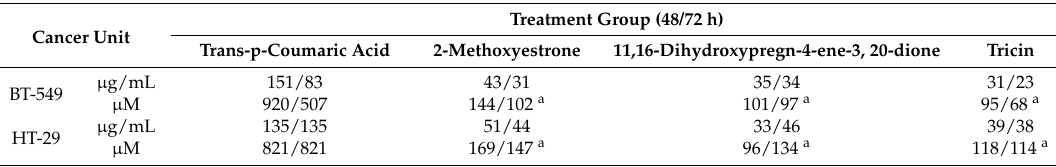
Table 3. IC50 of compounds ( 1 )–( 4 ) on BT-549 and HT-29 cancer cell